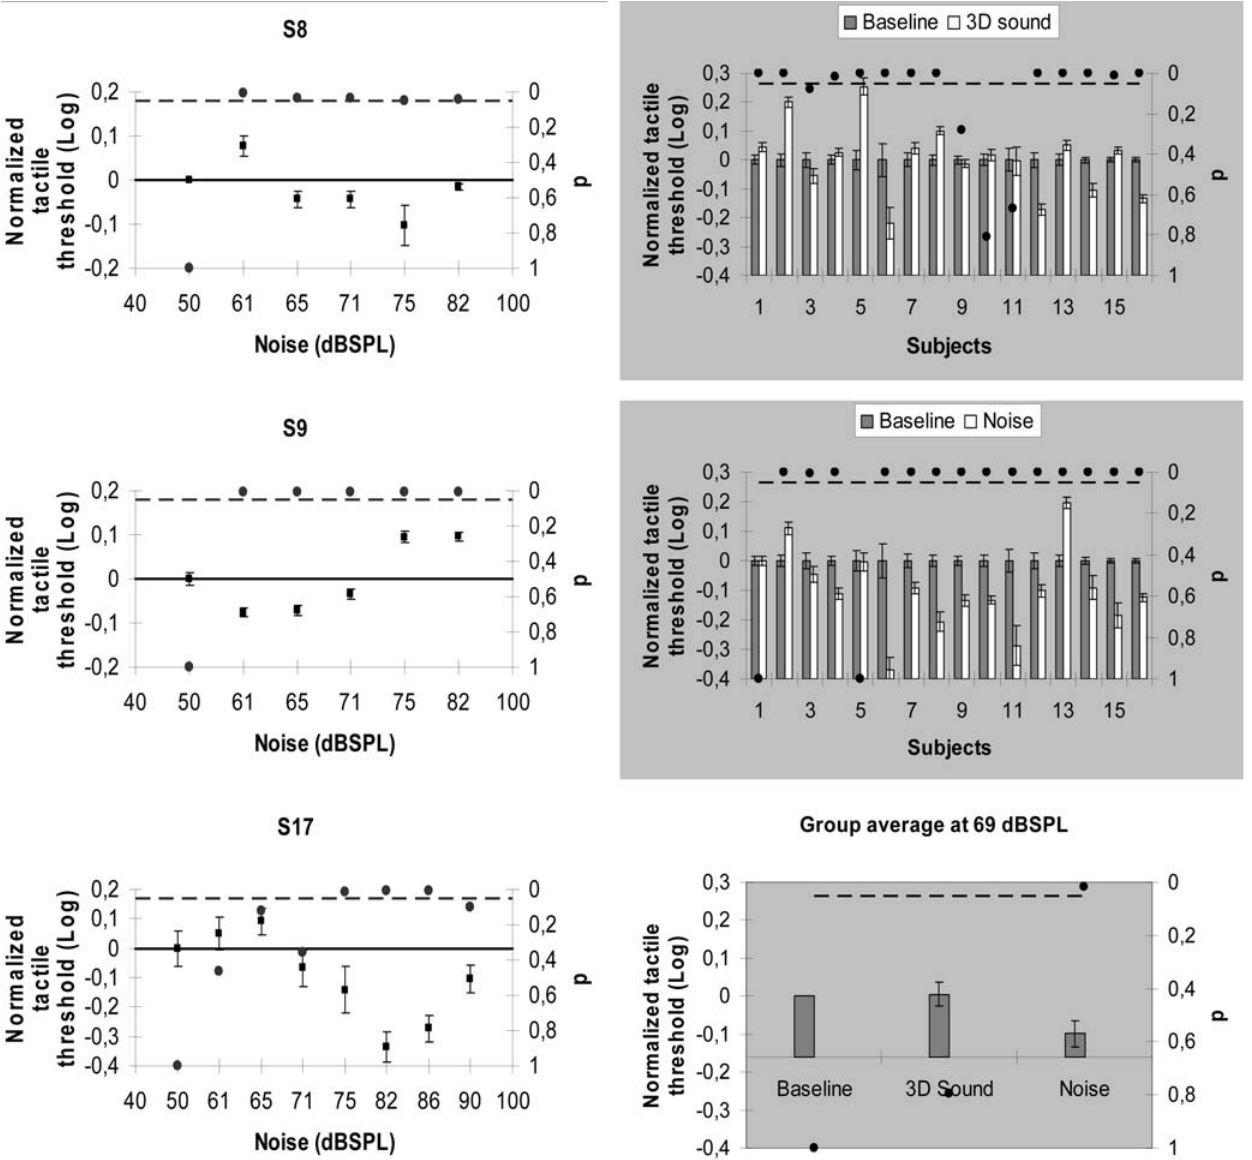
Figure 1. SR interactions between auditory noise and tactile signals. (Left column) normalized tactile threshold changes with the noise level in three subjects. (Right column, top) normalized tactile thresholds of sixteen subjects when the 3D sound level was fixed at 69 dBSPL. (Right column, middle) normalized tactile thresholds of sixteen subjects when the noise level was fixed at 69 dBSPL. (Right column, bottom) Group average results for three conditions: baseline, 3D sound and noise. The average group threshold decreased significantly in the presence of noise (p , 0.001) and no significant change was found for the 3D-like sound (p=0.72). In all the graphs the no-noise condition is taken as baseline; the black dots indicate p- values (right y-axis) and the broken line represents the 5% significance level. Error bars correspond to one standard